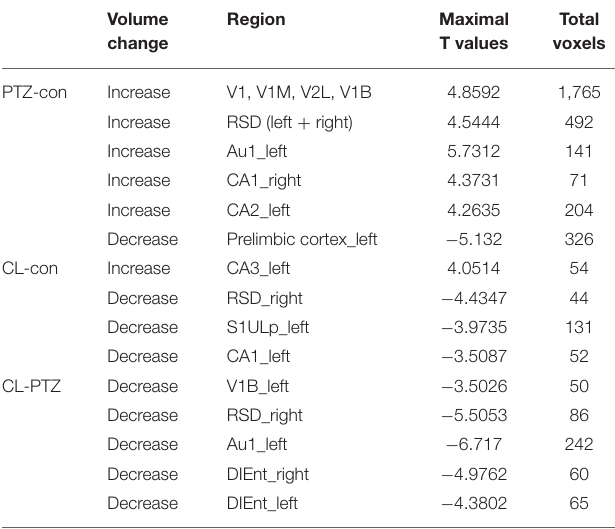
TABLE 1 | Changes in gray matter volume (GMV) as compared to the control